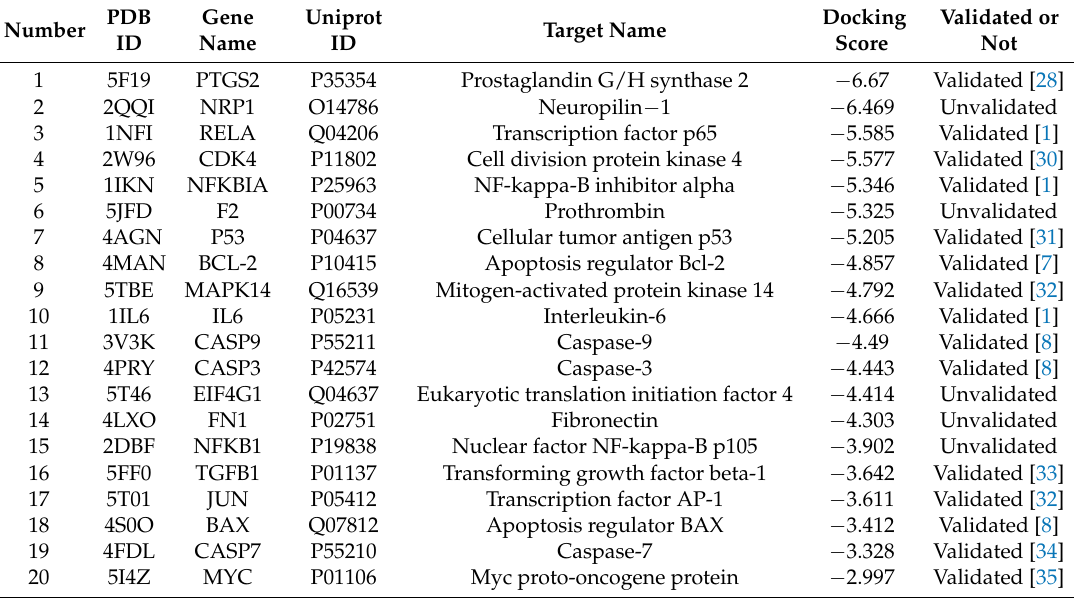
Table 1. Docking results of SSd and potential